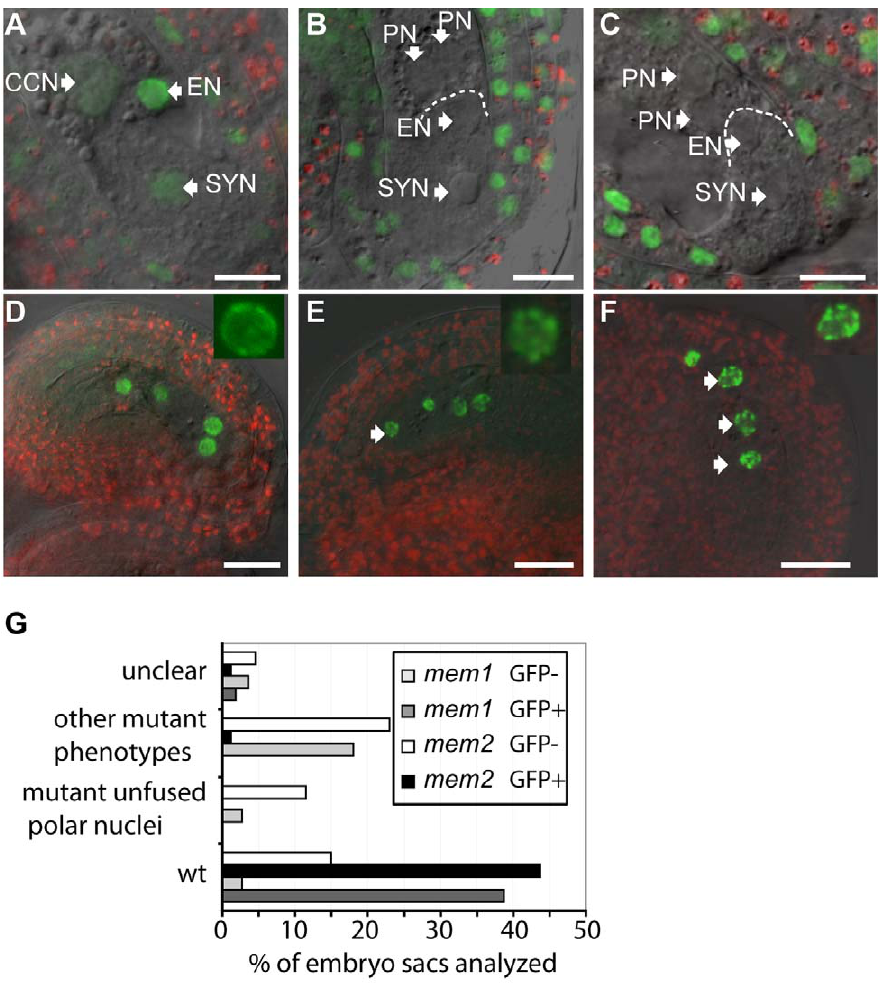
Figure 7. Studies of changes in the epigenetic landscape in mem-1 and mem-2 mutant gametophytic nuclei. (A–F) GFP and YFP signals were studied by confocal microscopy. Scale bars are 20 m m. Arrows point to nuclei. (A–C, G) Analysis of TFL2-GFP expression under the control of the TFL2 promoter in mem heterozygous plants. Fluorescence of the GFP marker protein was observed in nuclei of central cell (CCN), egg cell (EN), and synergids (SYN), indicating binding of the TFL2-GFP fusion protein to H3K27me3 methylation marks (A). No GFP signals were observed in mutant mature gametophytes with two unfused polar nuclei (PN) in mem-1 (B, G) and mem-2 mutants (C, G) and rarely in ovules with other mutant phenotypes (G). (D–F) Analysis of H2B-YFP expression under the control of the AKV promoter in plants heterozygous for the mem-1 (D, E) and mem-2 allele (F). The AKV cell identity marker expressed in developing gametophytes indicates a more condensed heterochromatin structure in some nuclei of mutant gametophytes (arrows point to nuclei; insets: signal distribution in wild-type (D) and mutant nuclei (E, F)). (G) Percentages of mutant phenotypes and presence ( + ) or absence ( 2 ) of GFP signal due to the TFL2-GFP marker observed in a total of N =111 and N =87 mature embryo sacs analyzed from mem-1/MEM and mem-2/MEM plants, respectively. GFP signal was only occasionally observed in mutant ovules. If embryo sacs could not clearly be classified as mutants or wild-type, they were recorded as ‘‘unclear’’; if they were clearly mutant but the central cell nuclei/us was/were not visible, they were recorded under ‘‘other mutant phenotypes.’’ The latter class includes 8% of mem-2/MEM ovules without GFP signal that likely had unfused polar nuclei, which were, however, not clearly visible. In contrast, GFP signal was observed in 93% and $ 78% of the wild-type ovules in the mem-1 and mem-2 mutants,